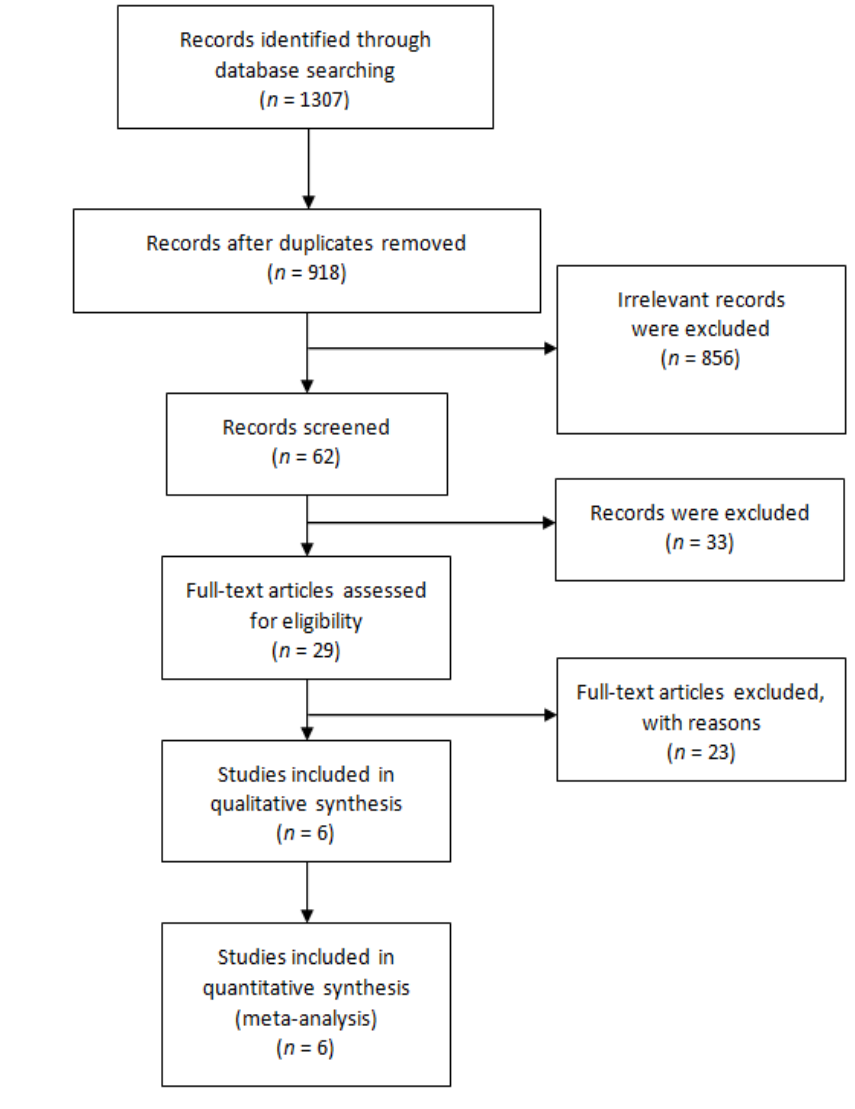
Figure 1. The PRISMA flow diagram.